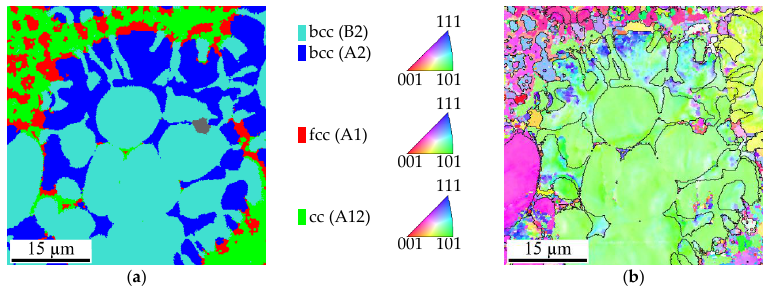
Figure 6. Al 0.8 CoCrFeNiTi ( a ) phase map and ( b ) orientation distribution, color-coded according to the unit triangle of the (IPF).